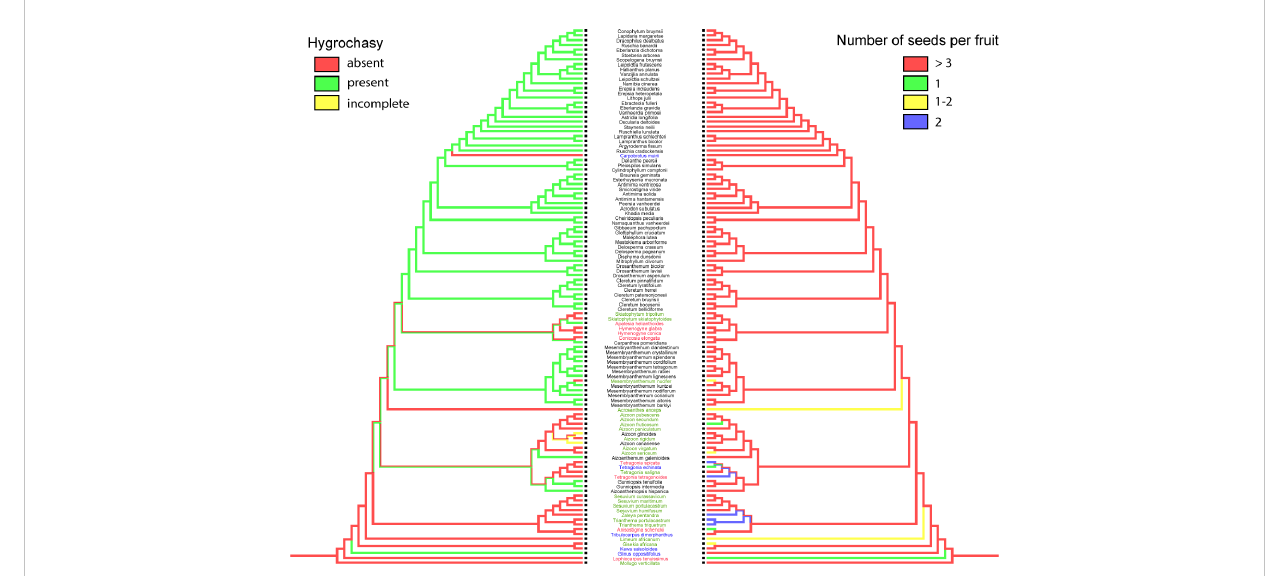
FIGURE 11 Ancestral character reconstruction of hygrochasy and number of seeds per fruit. Species names were highlighted in different colors indicating their mode of dispersal: black: ombrohydrochory, blue: zoochory, green: autochory, red: anemochory.